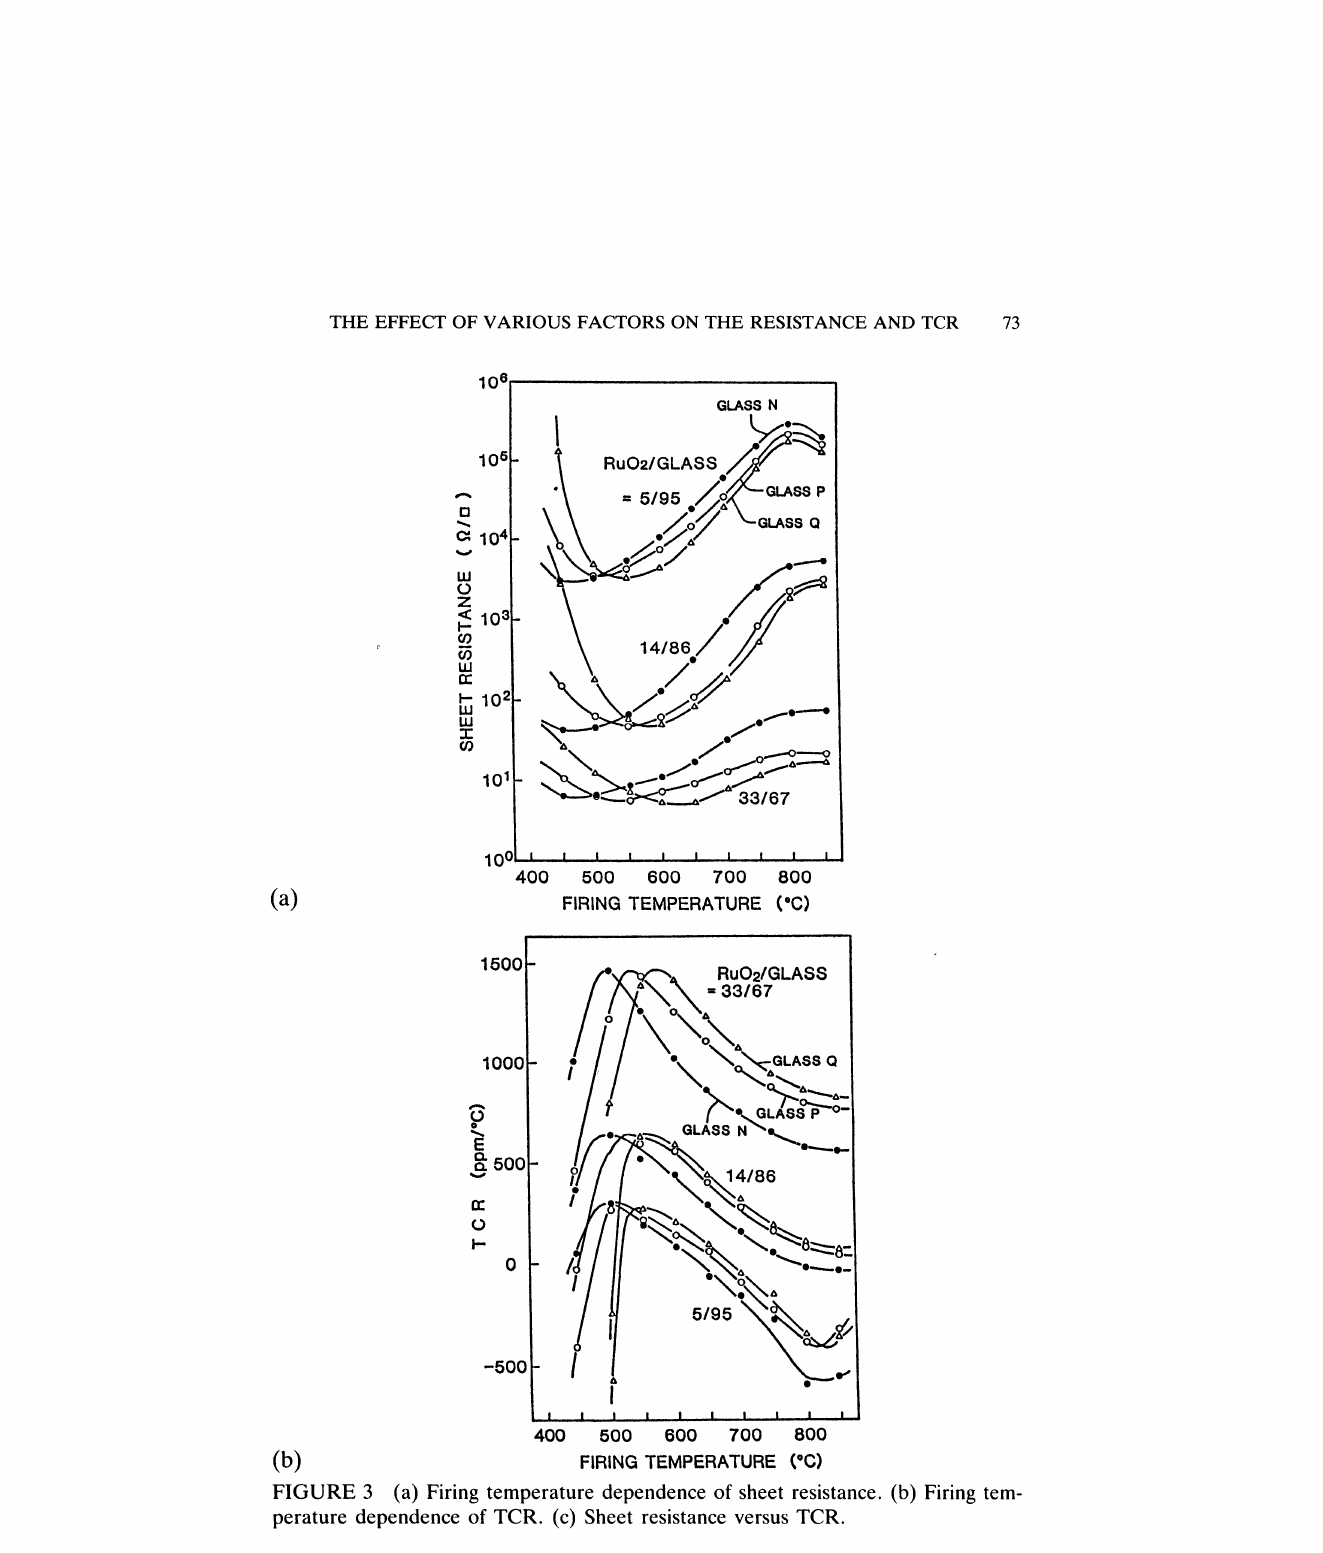
FIGURE 3 (a) Firing temperature dependence of sheet resistance. (b) Firing tem- perature dependence of TCR. (c) Sheet resistance versus